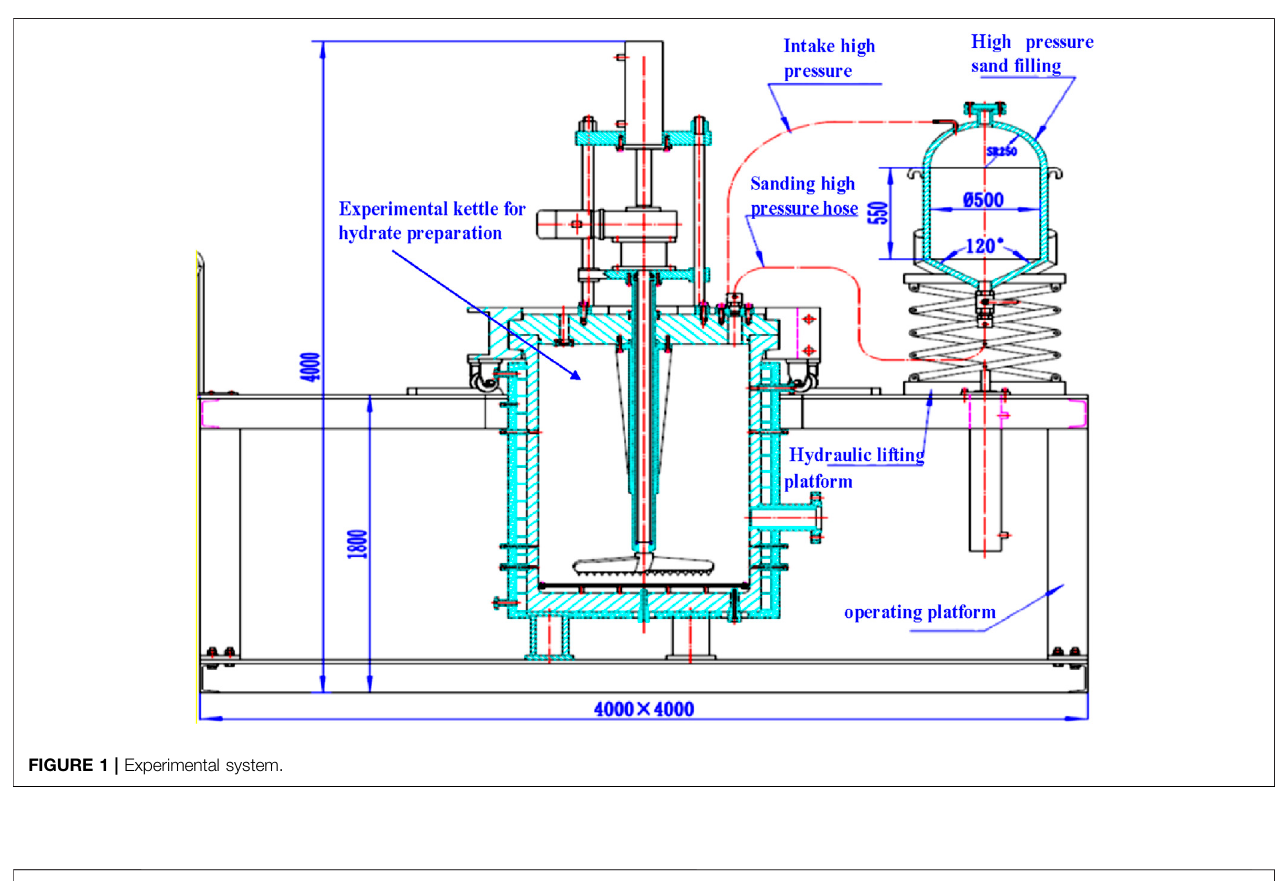
FIGURE 1 | Experimental system.